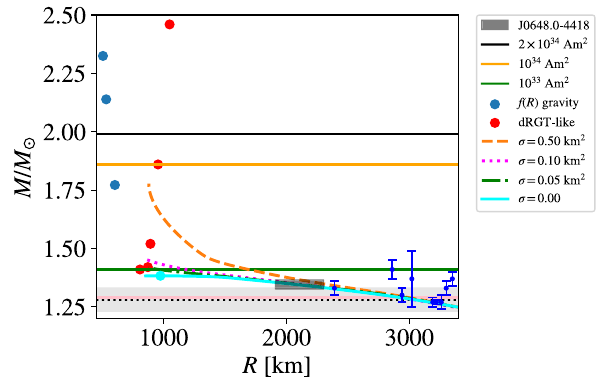
Fig. 5 Mass radius relationship for white dwarfs with different σ parameters and considering a star made of 12 C. Four values of σ were considered. For σ = 0 . 0, the theory represents General Rela- tivity. The black-shaded region indicates the observed mass-radius of ZTFJ1901+1458, this region, i.e., the mass-radius are taken from Ref. [66].Theblackdotted-lineandshadedregionare1 . 28 ± 0 . 05 M (cid:2) corre- sponding to RX J0648.0-4418 [83]. The pink line represents the upper limit of the compact object in AR Scorpii [84]. The blue circles with error bars represent the observational data of a sample of massive WDs taken from Refs. [81,82]. In this figure we have included the maximum mass of strongly magnetized 12 C WDs from Ref. [64]. They are repre- sented by the green, red, and black solid lines. These masses correspond to the following magnetic moments: 10 33 , 10 34 and 2 × 10 34 Am 2 . We also included two samples of mass-radius: from Ref. [29], which con- siders the f ( R ) gravity and from Ref. [36], which considers the Vegh’s massive gravity. They are represented by the blue and red dots, respec- tively